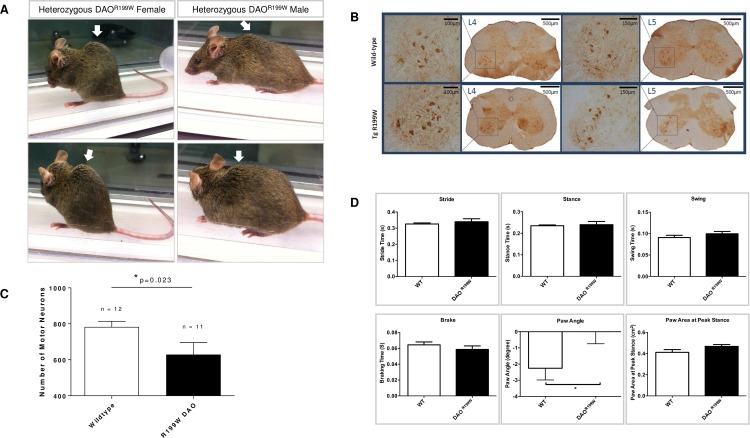
Phenotype of R199W DAO mouse showing (A) Kyphosis, (B) motor neuron loss in lumbar spinal cord, (C) ChAT immunohistochemisty in lumbar spinal cord (D) Assessment of various gait indices in the hindlimbs of female DAOR199W and wild-type littermates. (A) Kyphosis of the spine demonstrated in both male and female DAOR199W transgenic lines. The arrow denotes kyphosis of the spine. (B) Motor neuron counts in wildtype and R199W DAO mice aged 14–15 months. Lumbar motor neurons in regions L3-L5 were stained with anti-ChAT antibody and every third section quantified for both male and female wildtype and R199W DAO mice. The number of motor neurons in R199W DAO mice was reduced by 19.7% compared to wild-type mice (one-tailed, unpaired t-test, *p<0.05). When split by gender, motor neuron loss was significantly reduced by 25.7% in females (p = 0.0132*, one-tailed, unpaired t-test) but in males the reduction was by 16.5%, which was not significant. Histograms show means for 40 sections per animal ± SEM. (C) ChAT immunohistochemistry of L4 and L5 regions of a wild-type and transgenic animal with a DAOR199W mutation. Immunohistochemistry was performed on the lumbar spinal cord using anti-ChAT on 20μm sections of spinal cord. (A) Wild-type female L4 and L5 sections. (B) Female with DAO R199W mutation L4 and L5 sections. The number of ChAT-stained motor neurons in the female mice was 25.7% lower for the transgenic group compared to the wild-type group. (D) Assessment of various gait indices in the hind-limbs of female DAOR199W and wild-type littermates. Mean groups combined, plotted for hind-limbs of the DAOR199W (black bars) and WT (white bars) female mice. This was done through averaging the individual values generated by the DigiGait system for each hind-limb of a particular animal (n ≥ 10 per experimental group). Stride (sum of stance and swing), stance (weight bearing portion of the stride in which the paw remains in contact with the belt), swing (when the paw is not in contact with the belt) presented in the top panel, with P values of 0.5238, 0.7560 and 0.273 respectively (two-tailed, unpaired t-test, P < 0.05). Brake (time intervals between initial and maximal paw contacts with the belt), paw angle (angle of the hind-paw during peak stance in relation to the long axis of the body) and paw area at peak stance (maximal paw area in contact with the treadmill during the stance phase) presented in the bottom panel, with P values of 0.4509, 0.0435*, 0.0673 respectively (Mann-Whitney test carried out for brake time and two-tailed, unpaired t-test for the other two parameters, P < 0.05). Asterisk indicates a significant difference in term of the degree of paw angle between WT controls and DAOR199W mice. Values are standard error of the mean (±SEM).